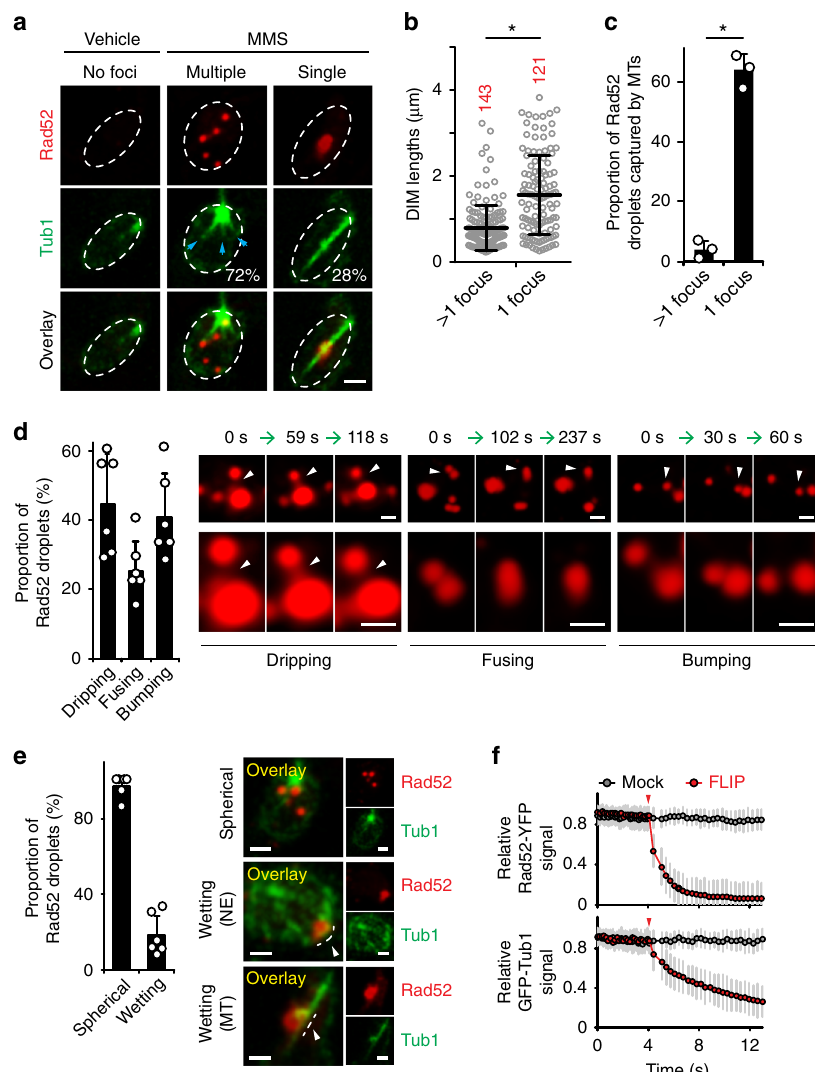
Fig. 1 DSB-indicating Rad52 forms liquid droplets in vivo. a – c Live-cell microscopy shows that nuclei with >1 Rad52 foci ( a ) exhibit shorter microtubule fi laments ( b ) that cannot capture the foci ( c ) ( n = 3). In a , shown are percentage of cells with given DIM species and pti-DIM-indicating blue arrowheads. d , e Rad52 foci exhibit liquid droplet behaviour ( n = 6). White arrowheads highlight relevant behaviours. f Rad52 foci dynamically exchange constituents with the nucleoplasm (Rad52 n = 30, Tub1 n = 12). Scale bars, 1 µ m. Quanti fi cations represent the mean ± s.d.; * P < 0.0001 in Mann – Whitney U ( b ) and χ 2 ( c ) tests. Source data are provided as a Source Data fi